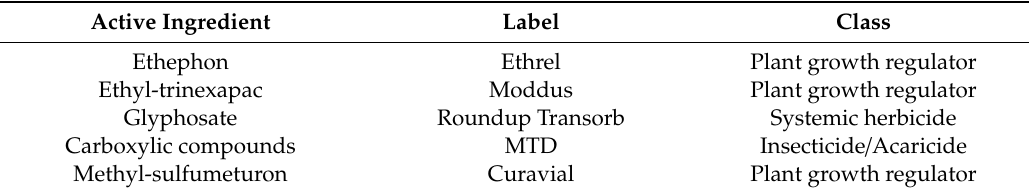
Table 1. Characterization of chemical ripening agents followed for the investigation of improvement of reactiveness of enzymatic antioxidant system of sugarcane